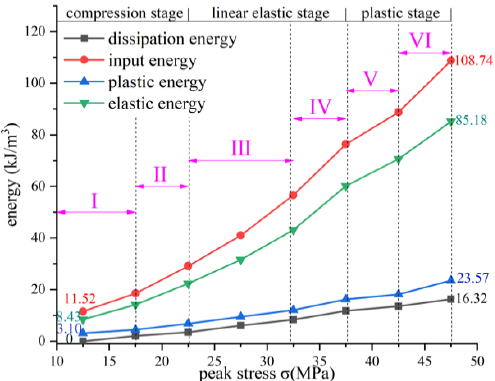
Figure 8. Change processes of various energies of L15 sample during loading and unloading. I: rapid increase of dissipation energy, II: constant dissipation energy, III: linear increase, IV: increase at the same speed, V: slow increase, VI: large increase before failure.